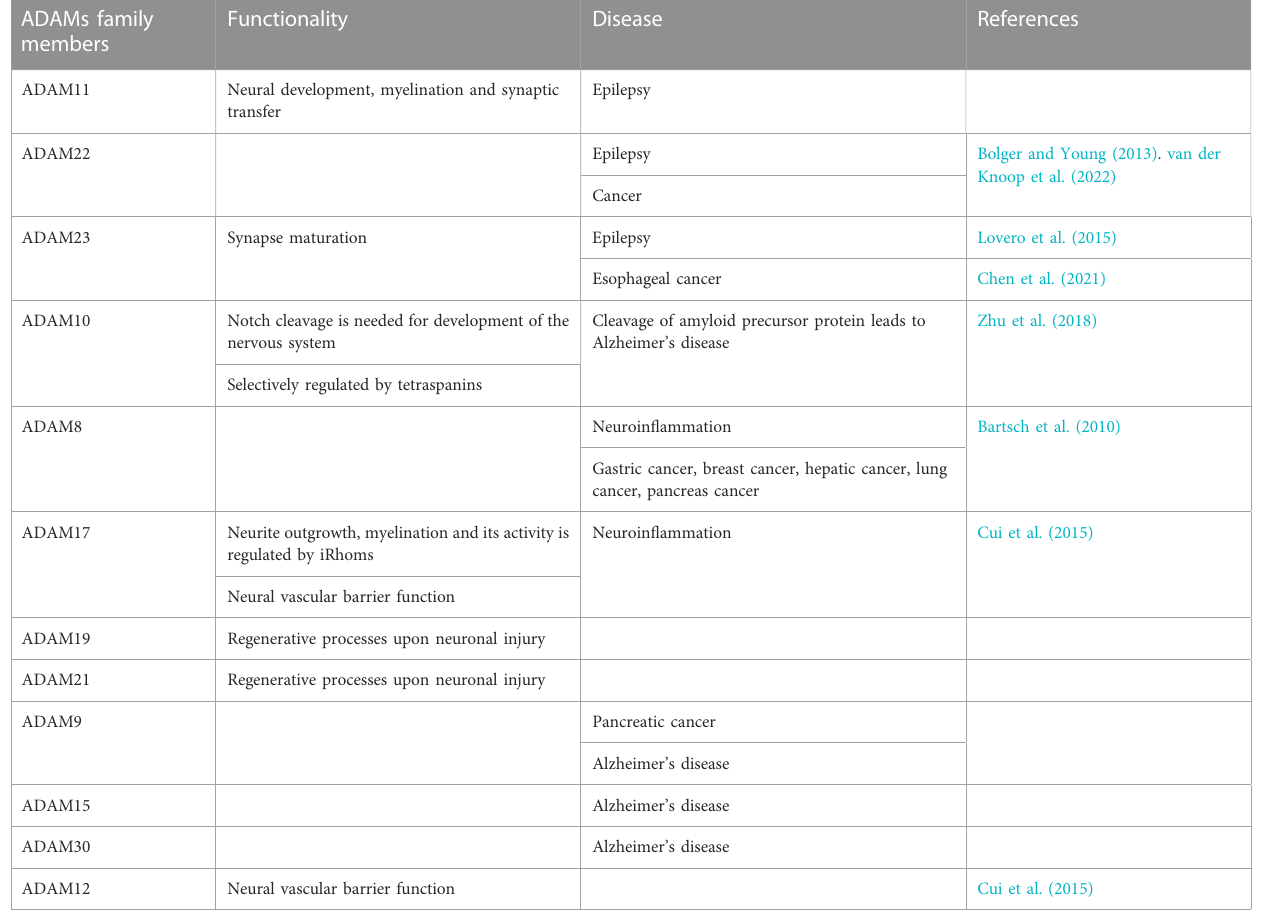
TABLE 1 Members of the family of ADAMs and their functions with a focus on disorders and diseases. ADAMs family